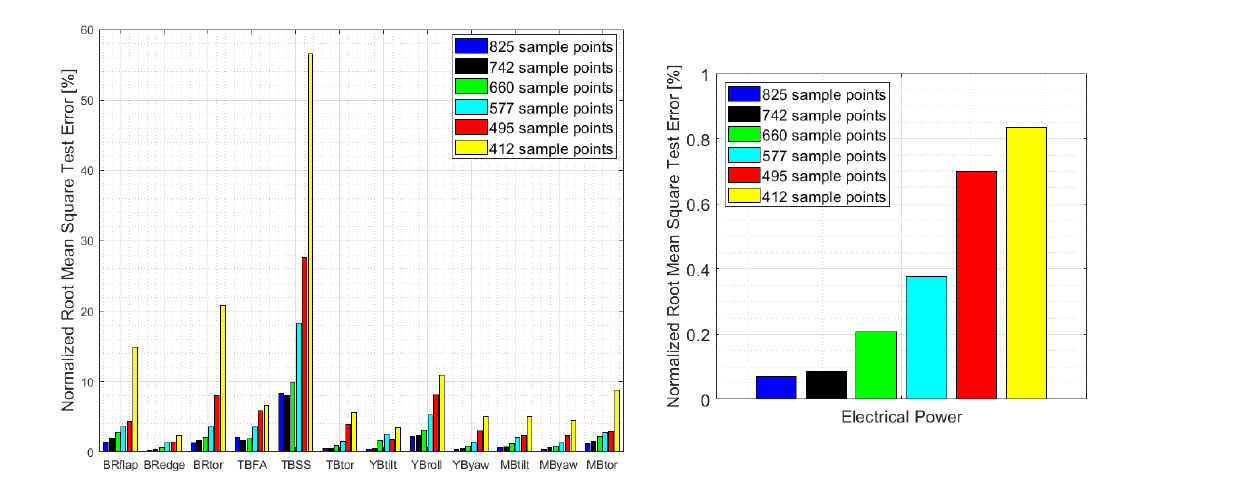
Figure 10. NRMSE of GPR for all DELs ( left ) and electrical power ( right ) for different sample